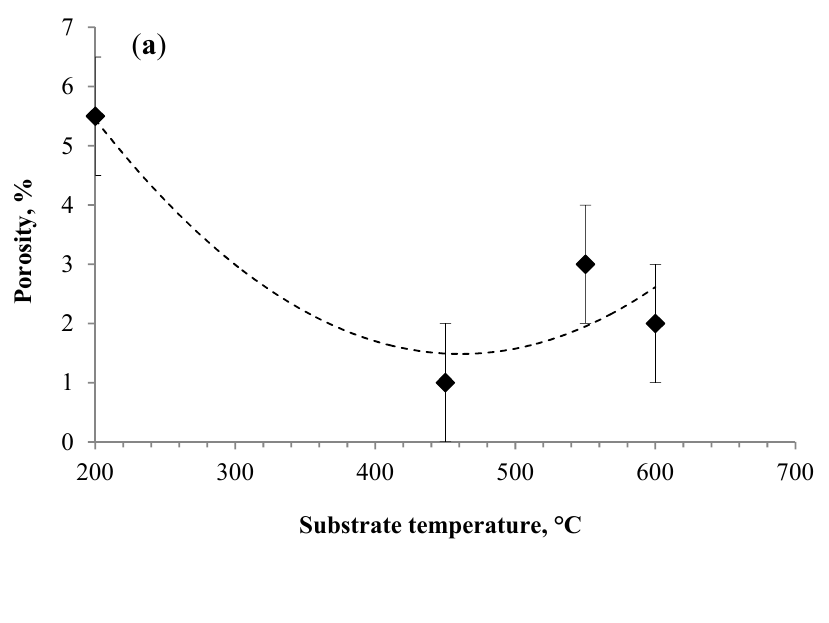
Figure 9. Influence of substrate temperature during thermal spraying on ( a ) porosity; ( b ) roughness and ( c ) adhesion strength and erosion